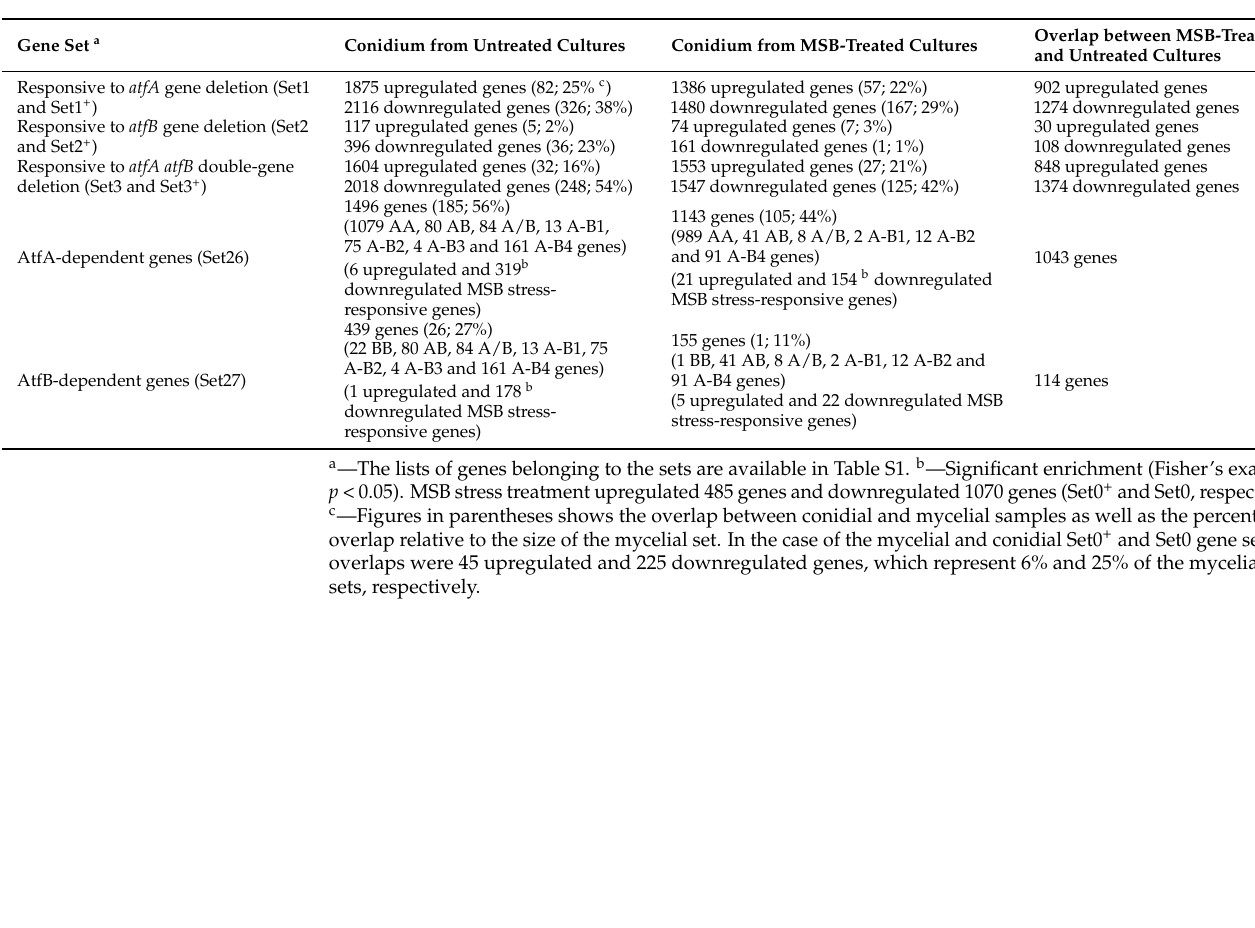
Table 2. Characteristics of the main gene sets identified with conidial